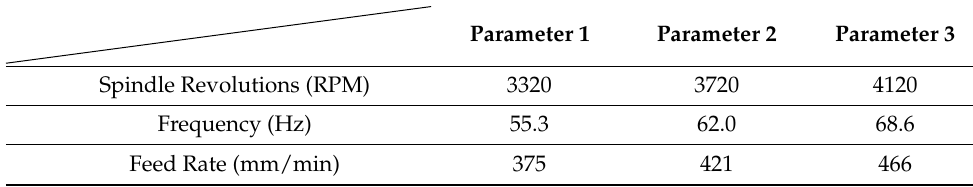
Table 9. D5 cutting parameters.